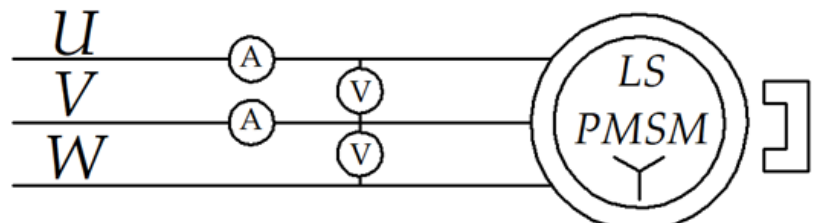
Figure 4. Electric sensors arrangement for the load test.